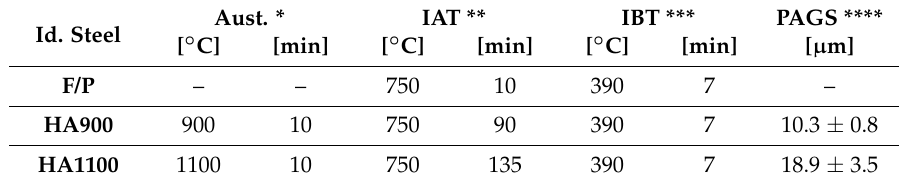
Table 1. Parameters used for the heat treatment cycles and austenite grain size after austenitization. Id.